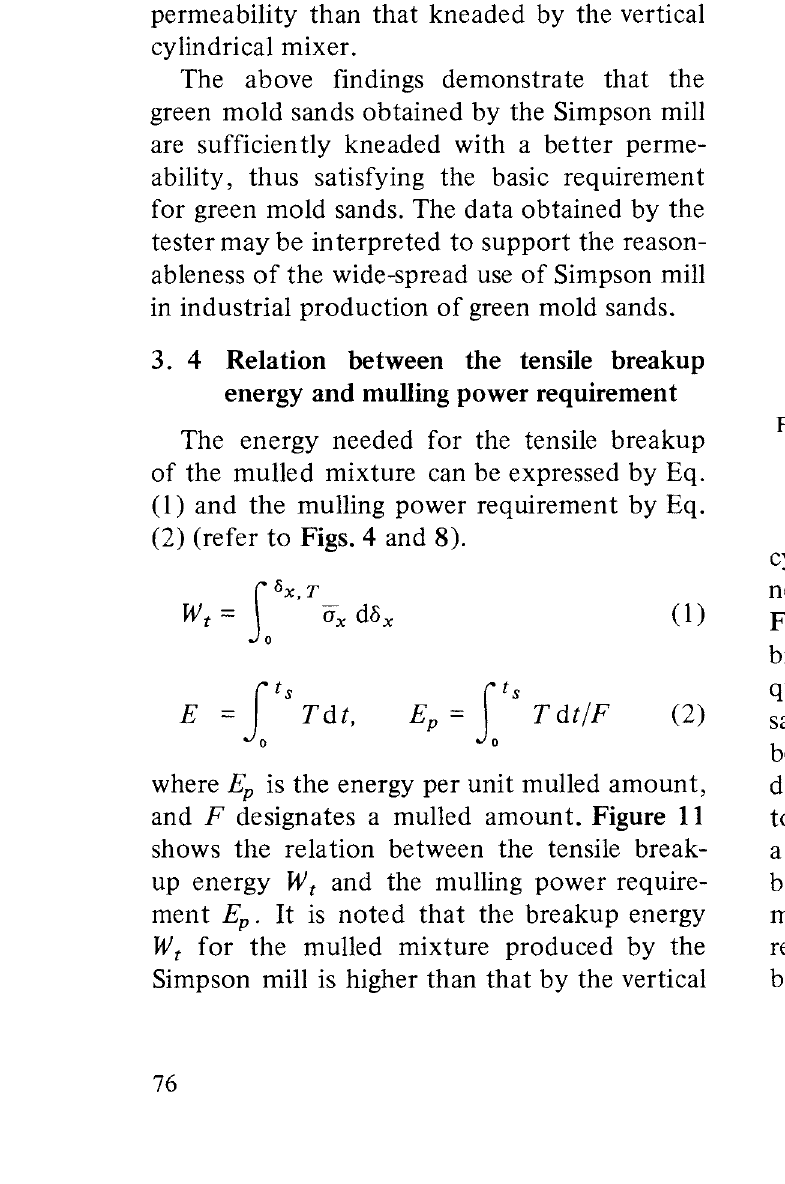
Fig. 11 Relation between tensile breakup energy and mulling power requirement by two types of kneaders